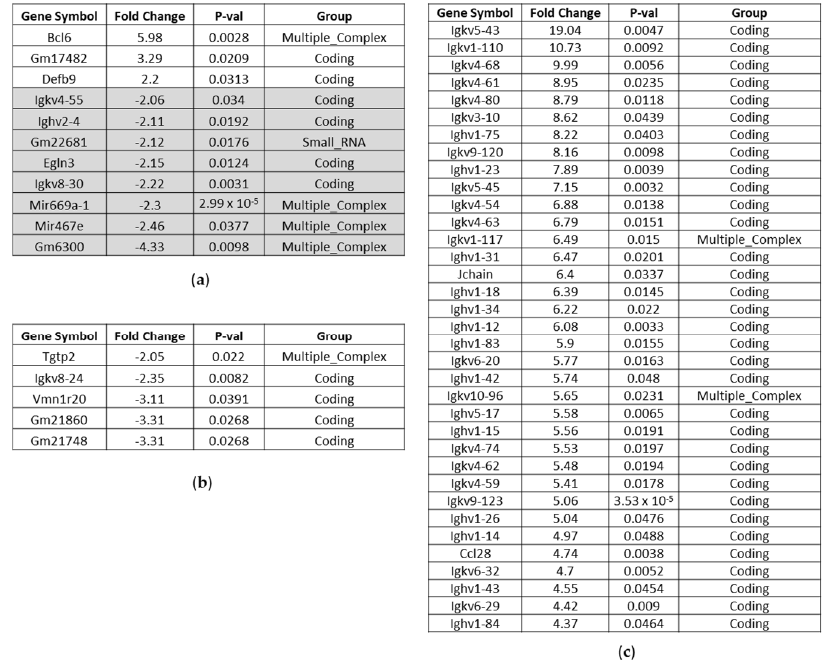
Figure 5. Affected genes in the kidney of BC- vs. control-fed mice. ( a ) Significantly up-regulated and down-regulated genes (highlighted in grey) after 2 days BC-fed mice compared to control-fed mice (up-regulated > 2.0; down-regulated < − 2.0). ( b ) Significantly down-regulated genes after 8 days BC-fed mice compared to control-fed mice (down-regulated < − 2.0). ( c ) Significantly up-regulated genes after 8 days BC-fed mice compared to control-fed mice (up-regulated ≥ 4.37; up-regulated > 2.0 see Supplemental Figure S3). Noncoding RNAs and pseudogenes are not included.